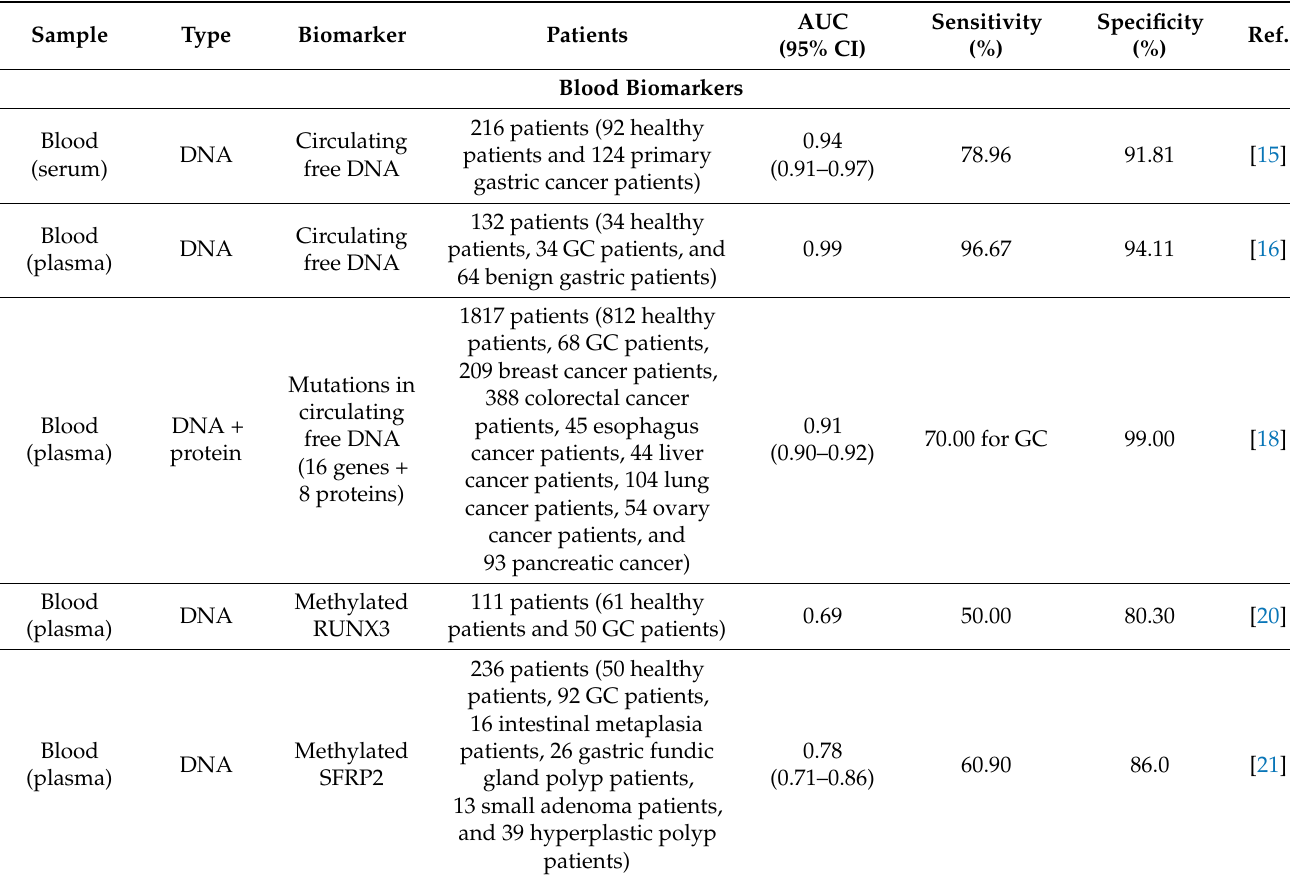
Table 1. Summary of potential biomarkers for gastric cancer screening and early diagnosis in blood.